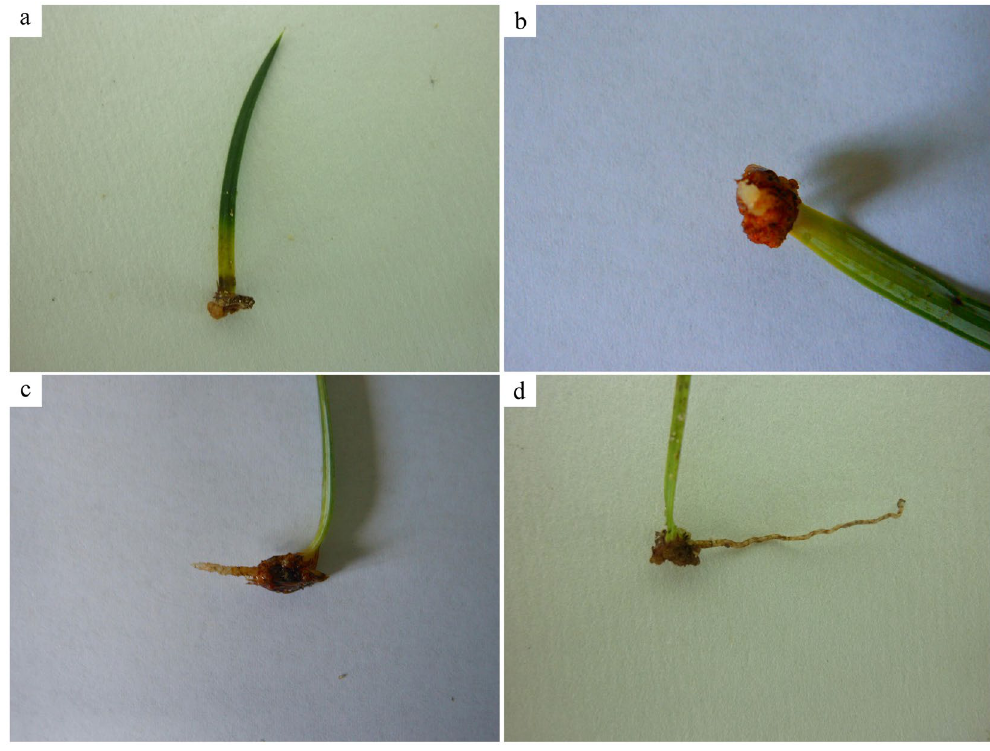
Figure 1. Callus and root initiation in a leaf cutting from Chinese fir. ( a ) Callus initiation 15 days after cutting; ( b ) adventitious root appears 50 days after cutting; ( c ) root growth at 60 days after cutting; ( d ) root growth at 90 days after